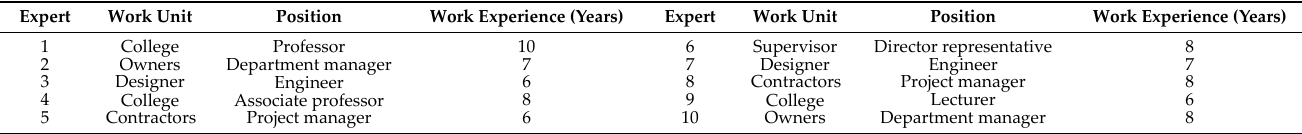
Table 1. Experts Information.